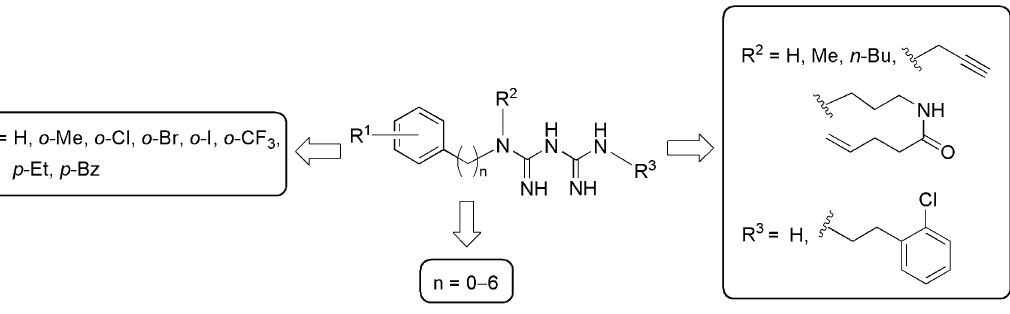
Figure 1. Structural modifications based on the aryl biguanide